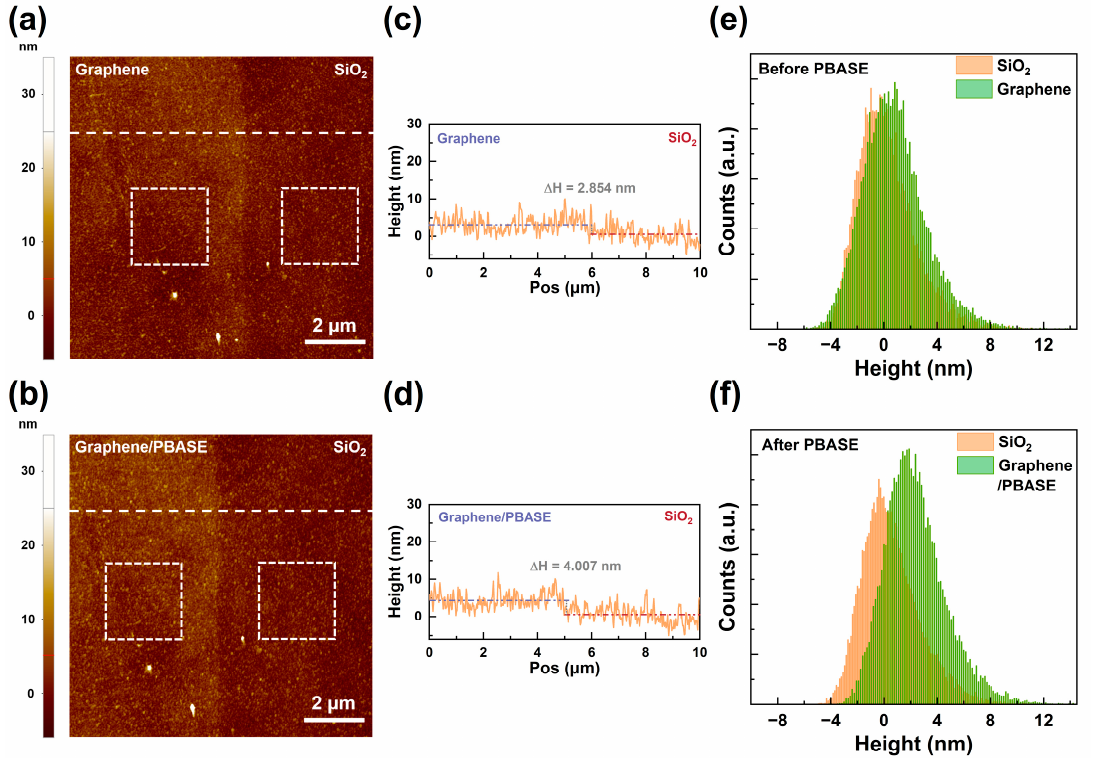
Figure 3. Atomic force microscope (AFM) characterization of graphene morphology before and after the non-covalent functionalization induced by PBASE, and the corresponding height profiles and histograms. ( a , b ): The AFM images of the graphene sheet and SiO 2 substrate before and after the adsorption of PBASE molecules, respectively. ( c , d ): The height profiles along the white dashed lines in ( a ) and ( b ), respectively. ( e , f ): The histograms of the height of graphene and SiO 2 substrate before and after the PBASE modification, respectively. The histograms are extracted from the white dashed boxes in ( a ) and ( b ), respectively. The area of each box is 2.5 × 2.5 µ m 2